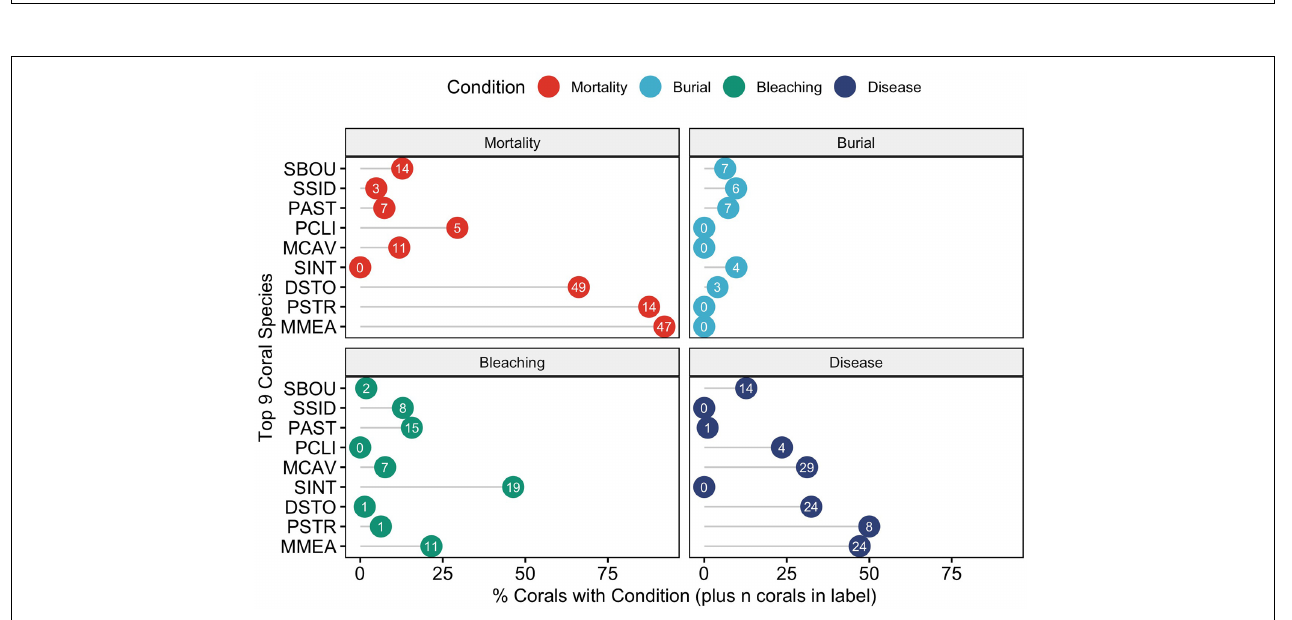
FIGURE 7 | Coral conditions plotted for each of the nine most abundant coral species – Solenastrea bournoni (SBOU), Siderastrea siderea (SSID), Porites astreoides (PAST), Pseudodiploria clivosa (PCLI), Montastrea cavernosa (MCAV) , Stephanocoenia intercepta (SINT), Dichocoenia stokesi (DSTO), Psuedodiploria strigosa (PSTR), and Meandrina meandrites (MMEA). The x -axis plots the percent of individual corals with the condition and the number shows the actual number of individuals with that condition.